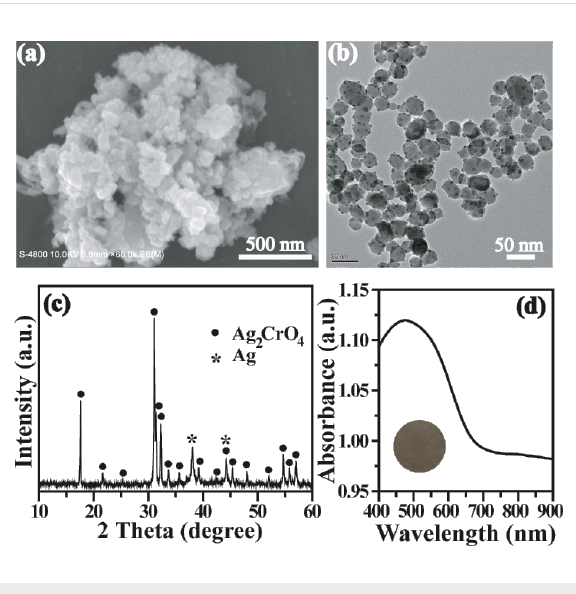
Figure 9: (a) SEM image, (b) TEM image, (c) XRD pattern, and (d) UV–visible spectrum of Ag 2 CrO 4 after five circles of photocatalytic